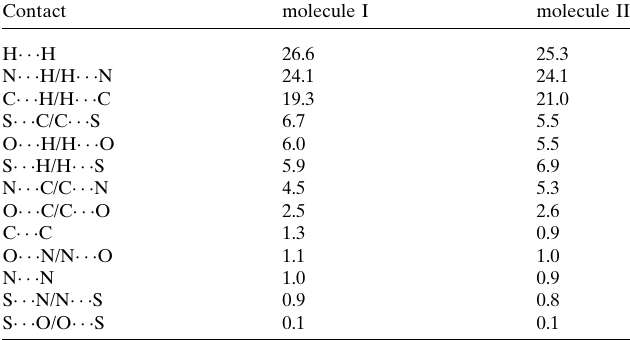
Table 3 Percentage contributions of interatomic contacts to the Hirshfeld surface for the title